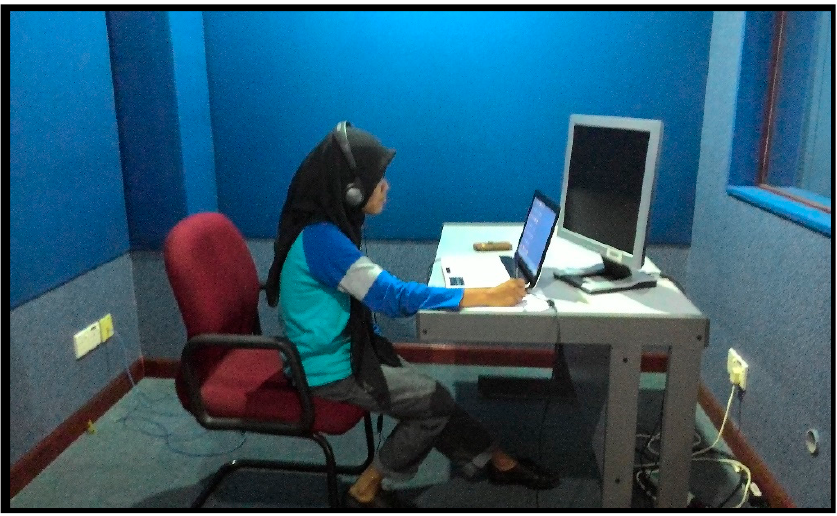
Figure 1. Example of the listening test environment.